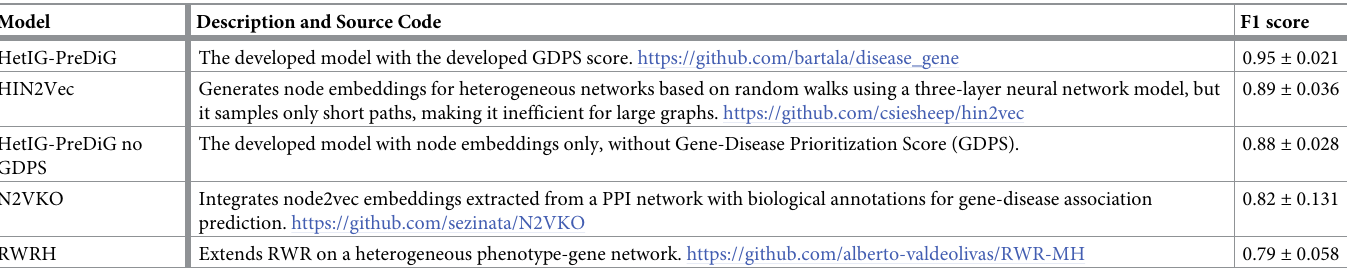
Table 2. Comparison of the developed model (HetIG-PreDiG) with the baseline models using 10-fold cross-validation for prediction of the top 30% of predicted dis- ease genes. The source code of baseline models is listed. The Micro-F1 score column indicates average and standard deviation model performance of predicting gene-dis- ease